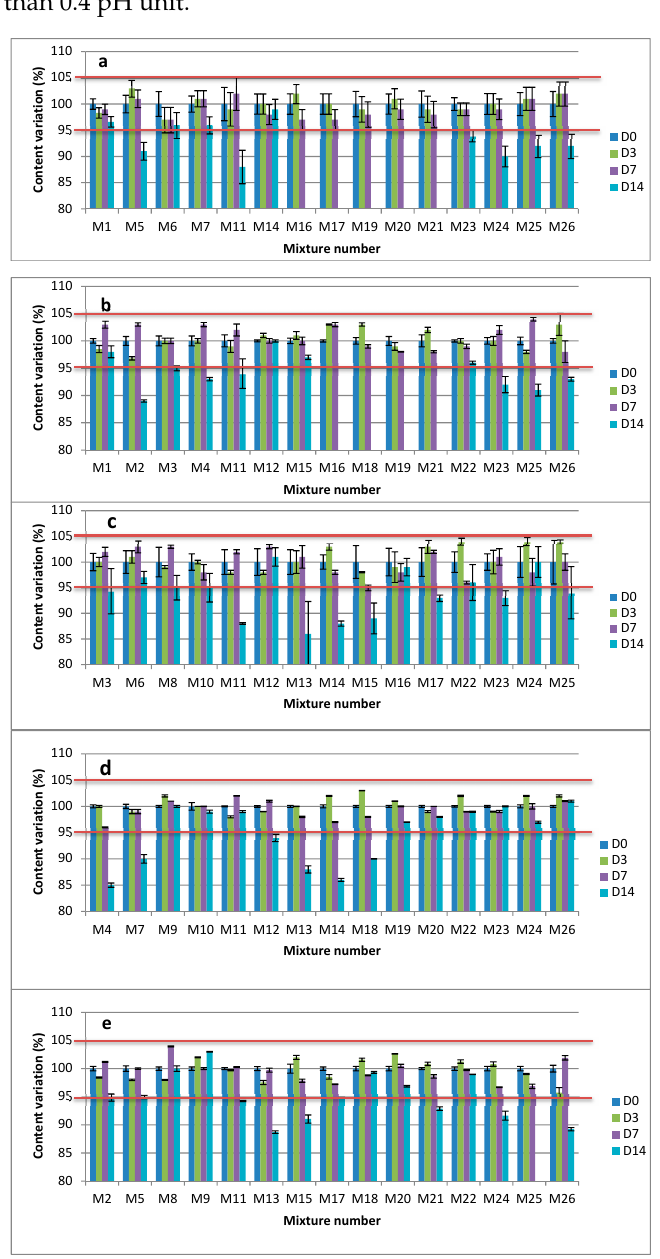
Figure 3. Observed concentrations of pure drugs (as mean percentage of initial concentration ± SD) in mixtures at 22 ± 3 ◦ C: ( a ) Clonidine; ( b ) Sufentanil; ( c ) Loxapine; ( d ) Midazolam; ( e )